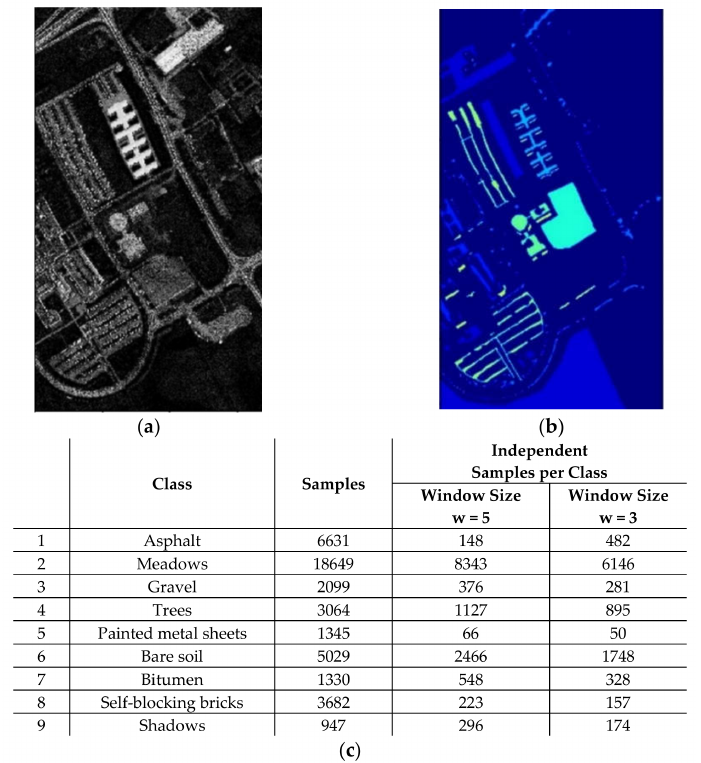
Figure 9. Hyperspectral remote sensing scenes from the Pavia University dataset for the most representative classes only: ( a ) sample band of the Indian Pines dataset, ( b ) reference map of the Indian Pines dataset, ( c ) reference map classes for the Pavia University scene and their respective samples